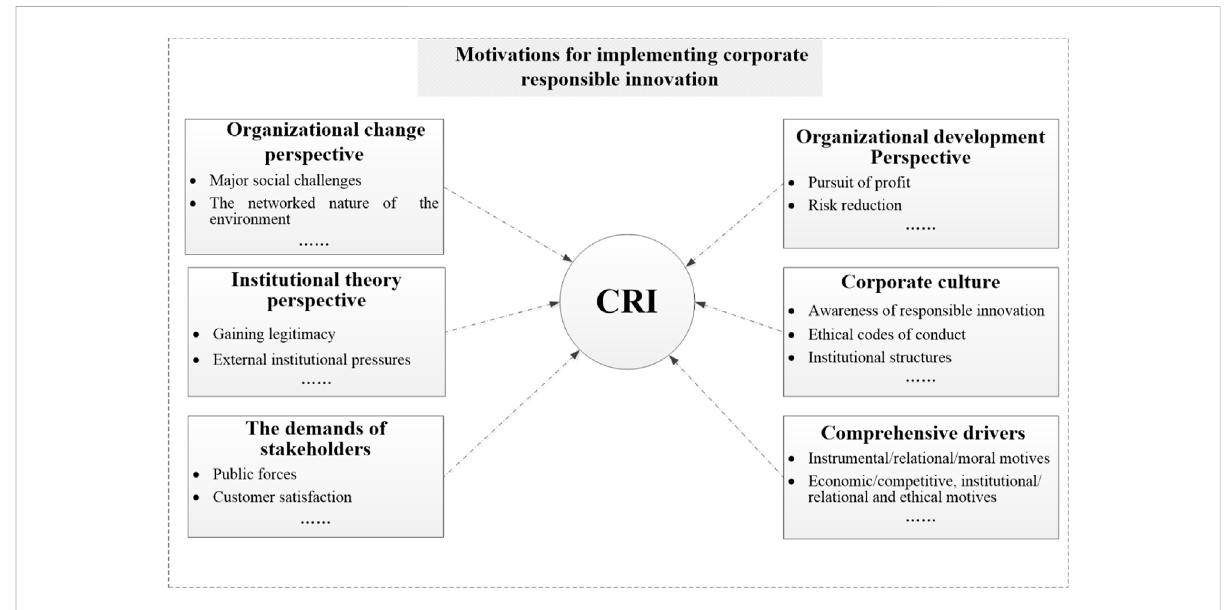
Motivations for implementing corporate responsible